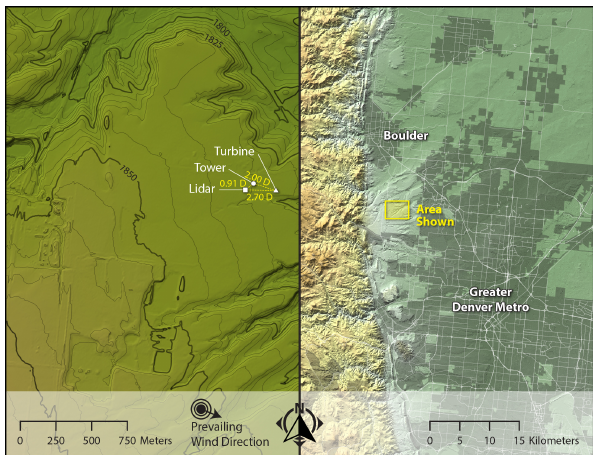
Figure 1. Left panel: local map of the NWTC with instrument lo- cations and topographic contours in meters above sea level. Right panel: the regional setting of the NWTC between the greater Denver metropolitan area and Boulder, with the Front Range of the Rocky Mountains shown in the higher topography west of the site. (Cour- tesy of Joshua Bauer and Billy Roberts at